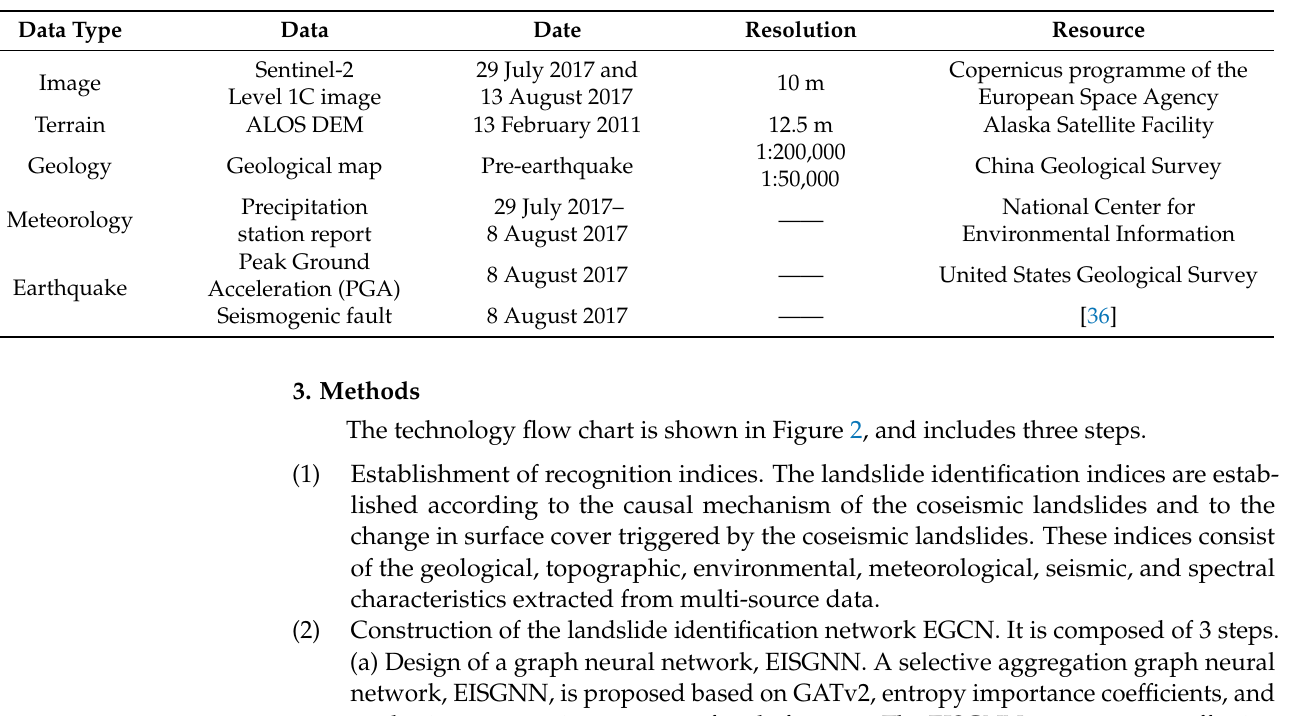
Figure 1. Overview diagram of the study area. PGA indicates the peak ground acceleration. Table 1. Multi-source data for coseismic landslide recognition. ALOS DEM indicates the digital elevation model produced from Advanced Land-Observing Satellite-1